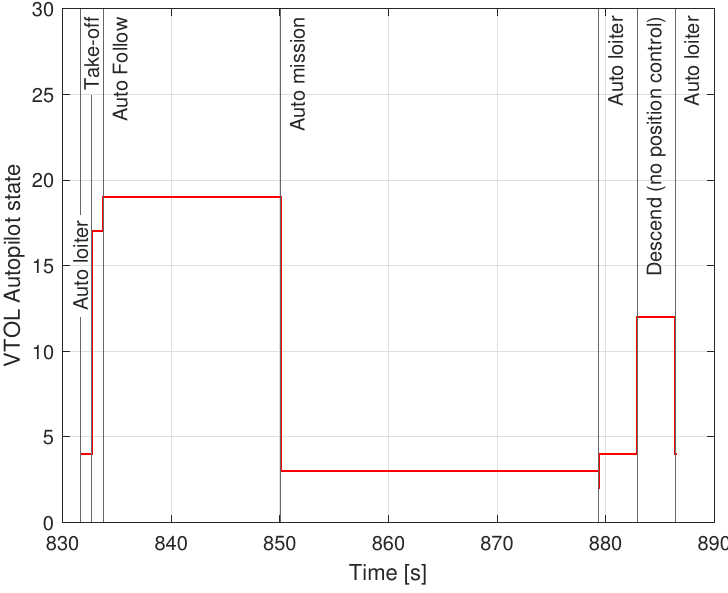
Figure 8. VTOL UAV states during crash